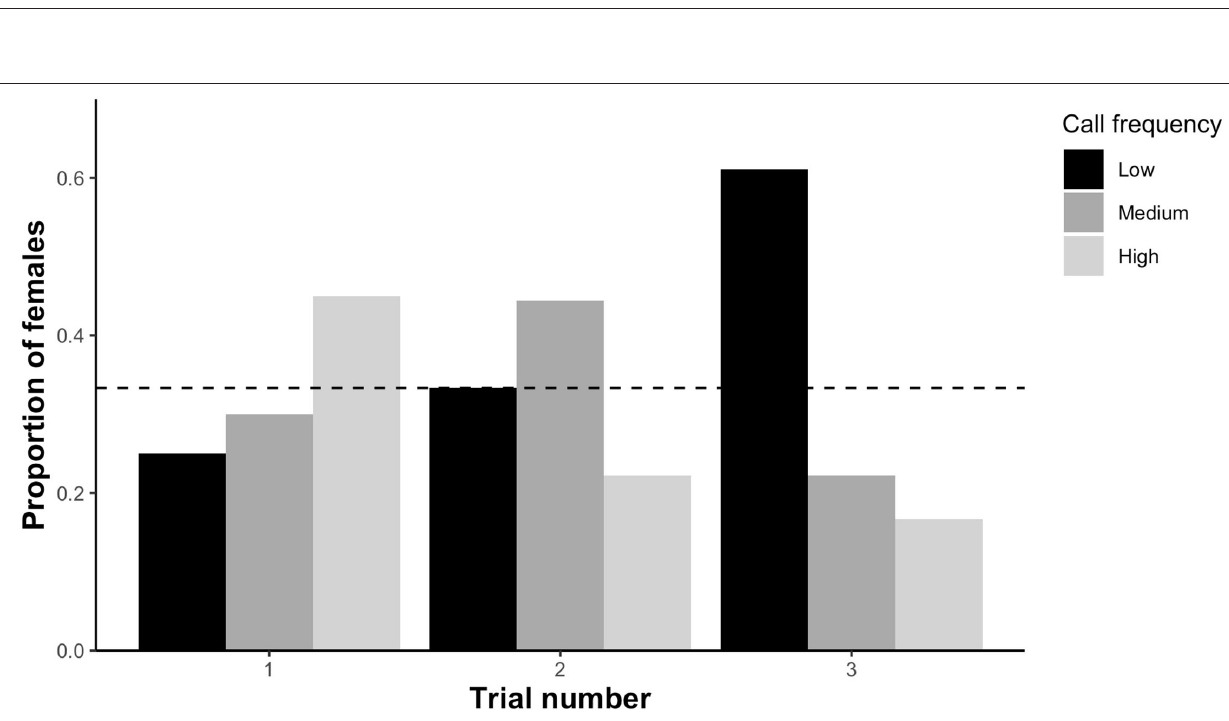
Frontiers in Conservation Science |